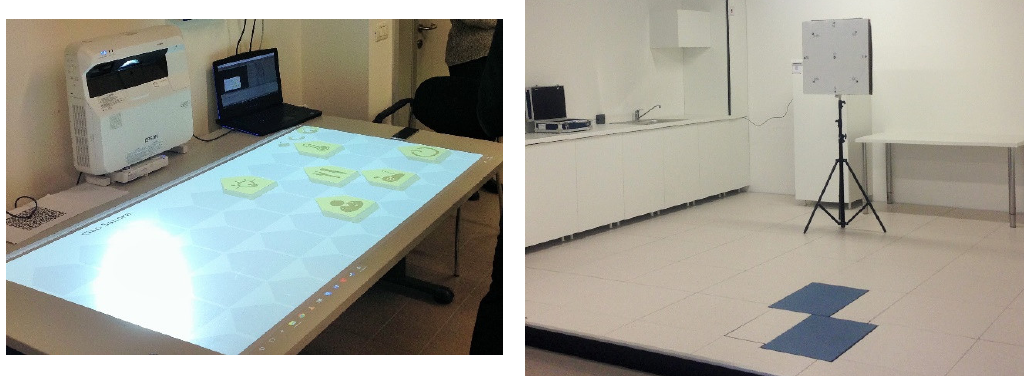
Figure 9. A picture of Home Interactive Controller (HIC) interface projected on a table ( left ), and Future Homes for Future Communities (FHfFC) Living Lab ( right ); in blue, on the floor, are the two force platforms.